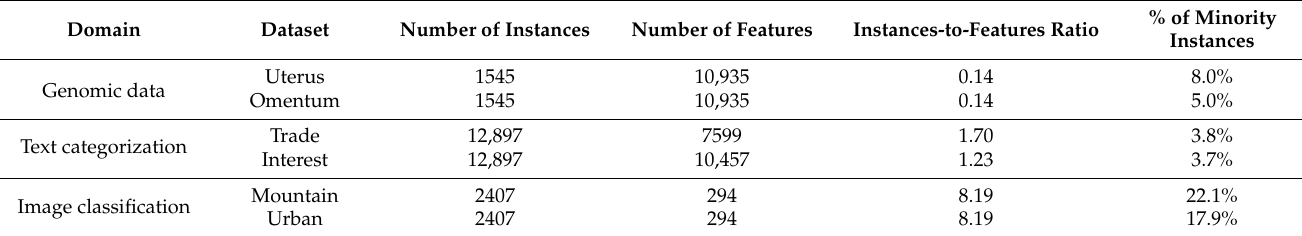
Table 2. Datasets used in the experimental